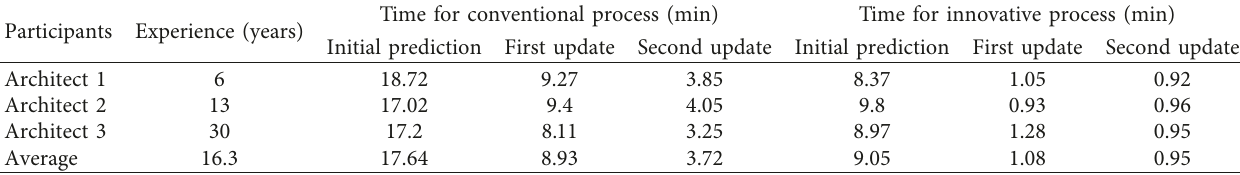
Figure 5: Charrette test design. Table 4: Time spent on Case 2.